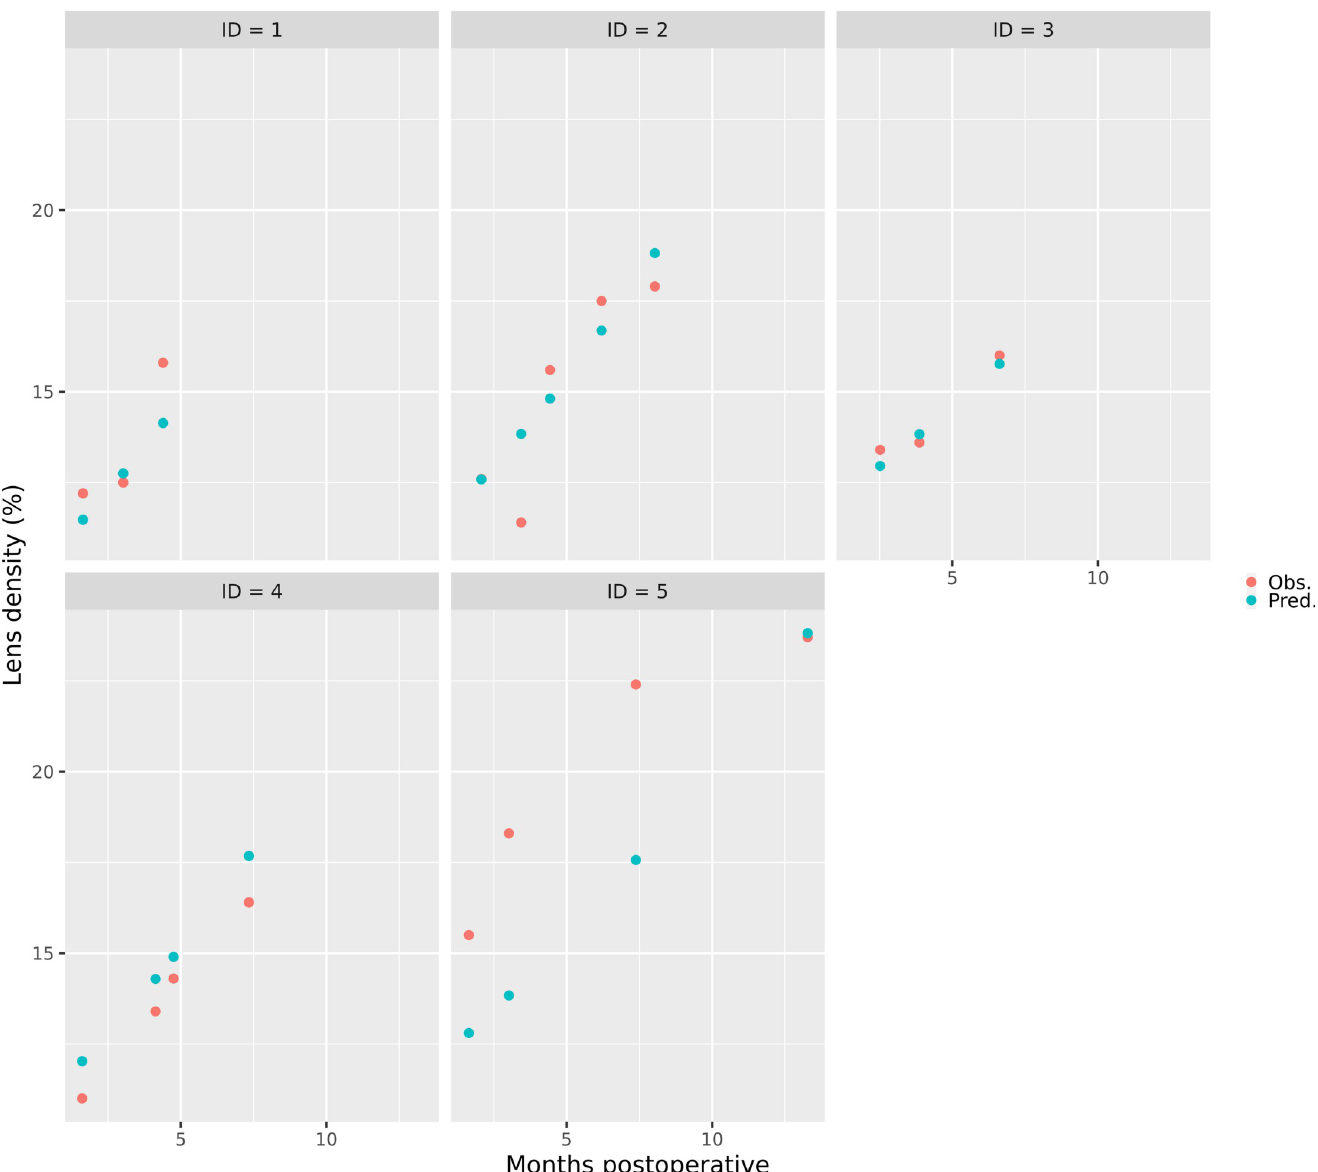
Fig 2. Predicted and observed lens densitometries over time. Predicted (blue dots) and observed (red dots) postoperative lens densitometries (%) over time (months after surgery).